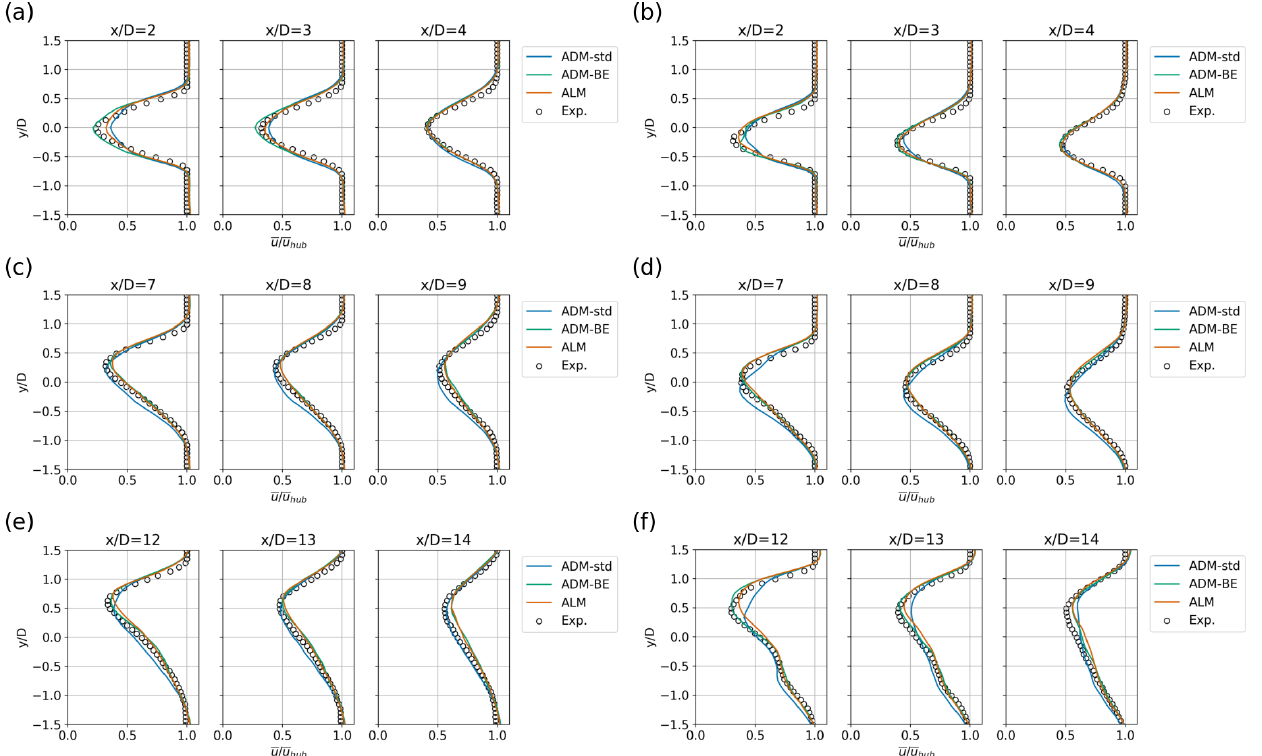
Figure 7. Profiles of the normalised streamwise mean velocity u/u hub in the x − y plane at hub height obtained from the wind-tunnel experiments and LES using the ADM-std, ADM-BE and ALM. The wind turbines are offset in the spanwise direction with a distance of D/ 3 (Cases 3 and 4). (a) WT 1, γ = (0 , 0 , 0 ◦ ); (b) WT 1, γ = (20 , 20 , 0 ◦ ); (c) WT 2, γ = (0 , 0 , 0 ◦ ); (d) WT 2, γ = (20 , 20 , 0 ◦ ); (e) WT 3,